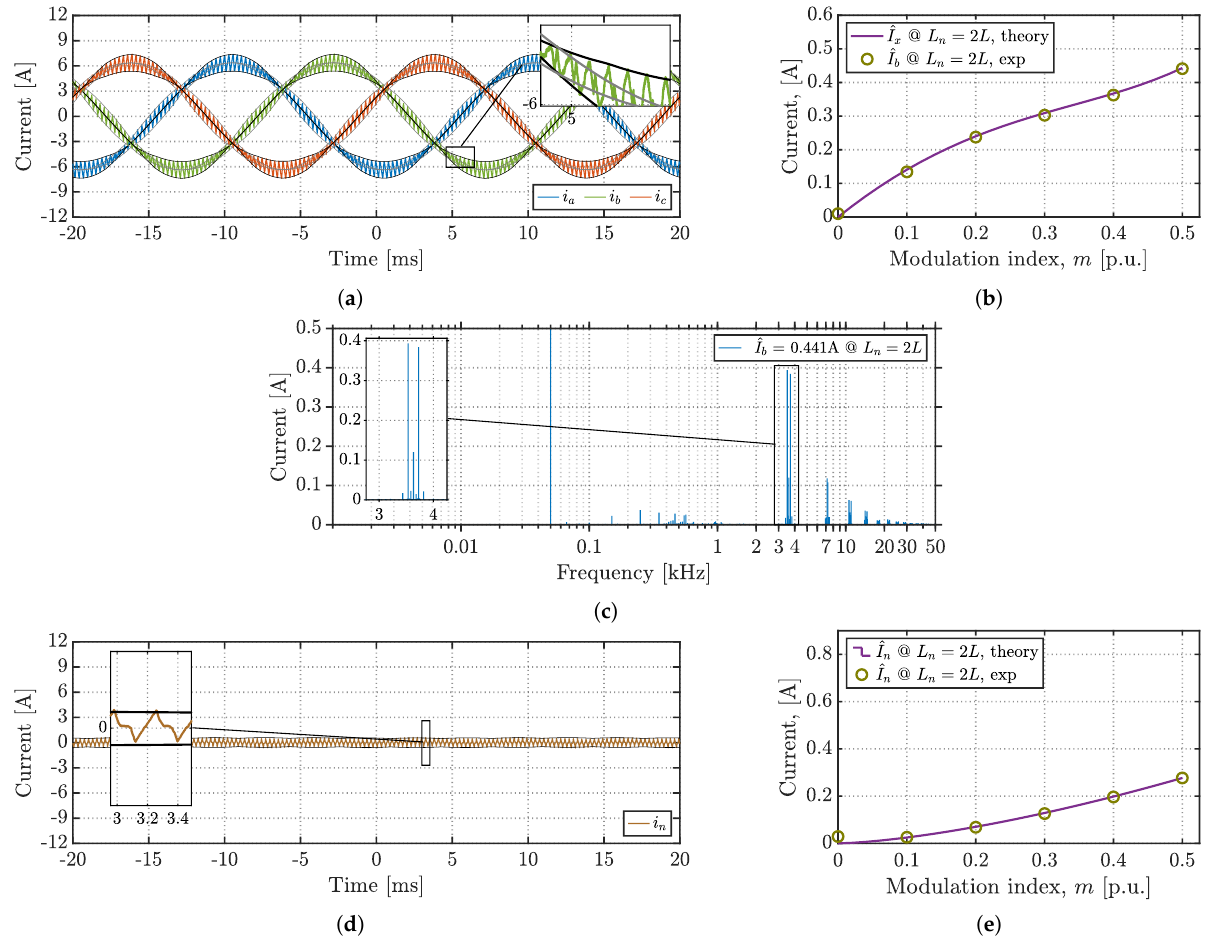
Figure 21. Experimental measurements of three-phase and neutral currents m = 0.5 and k = 2: ( a ) balanced three-phase currents along with their primary (black) and secondary (gray) current ripple envelopes, ( b ) RMS values of a phase current ripple (ph. b ), ( c ) harmonic spectrum of a phase current (ph. b ), ( d ) neutral current along with its current ripple envelope (black), and ( e ) RMS values of the neural current ripple.